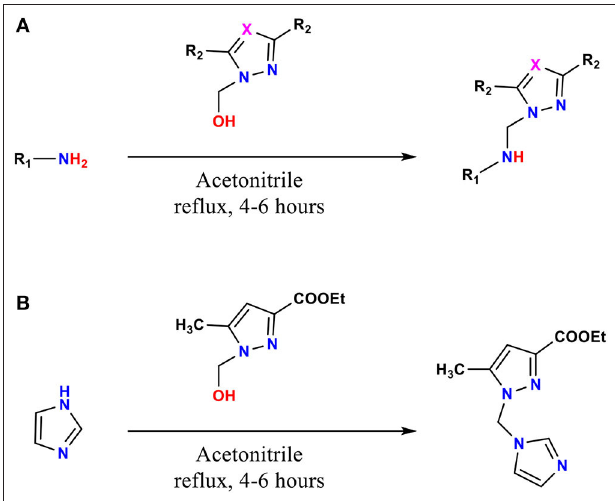
FIGURE 1 | The reaction procedure for the preparation of compounds 1 – 12 (pathway A,B